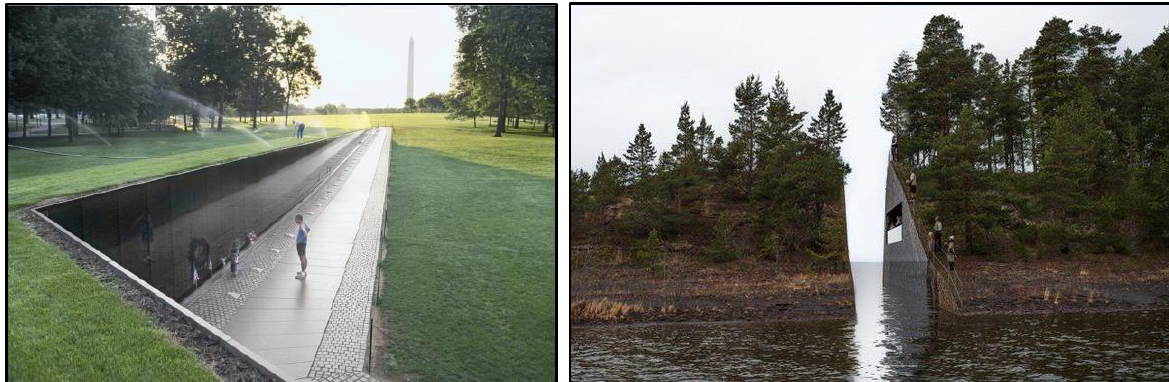
Figure 2. The Vietnam Veterans Memorial (Washington D.C., 1982) ( left ) and Utøya Memorial (Norway, never built) ( right ).